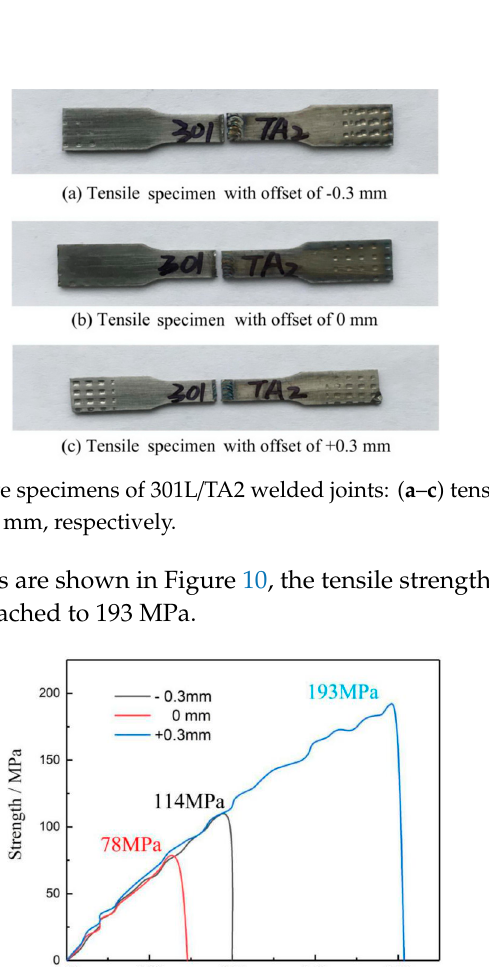
Figure 8. Dimension of tensile specimens.